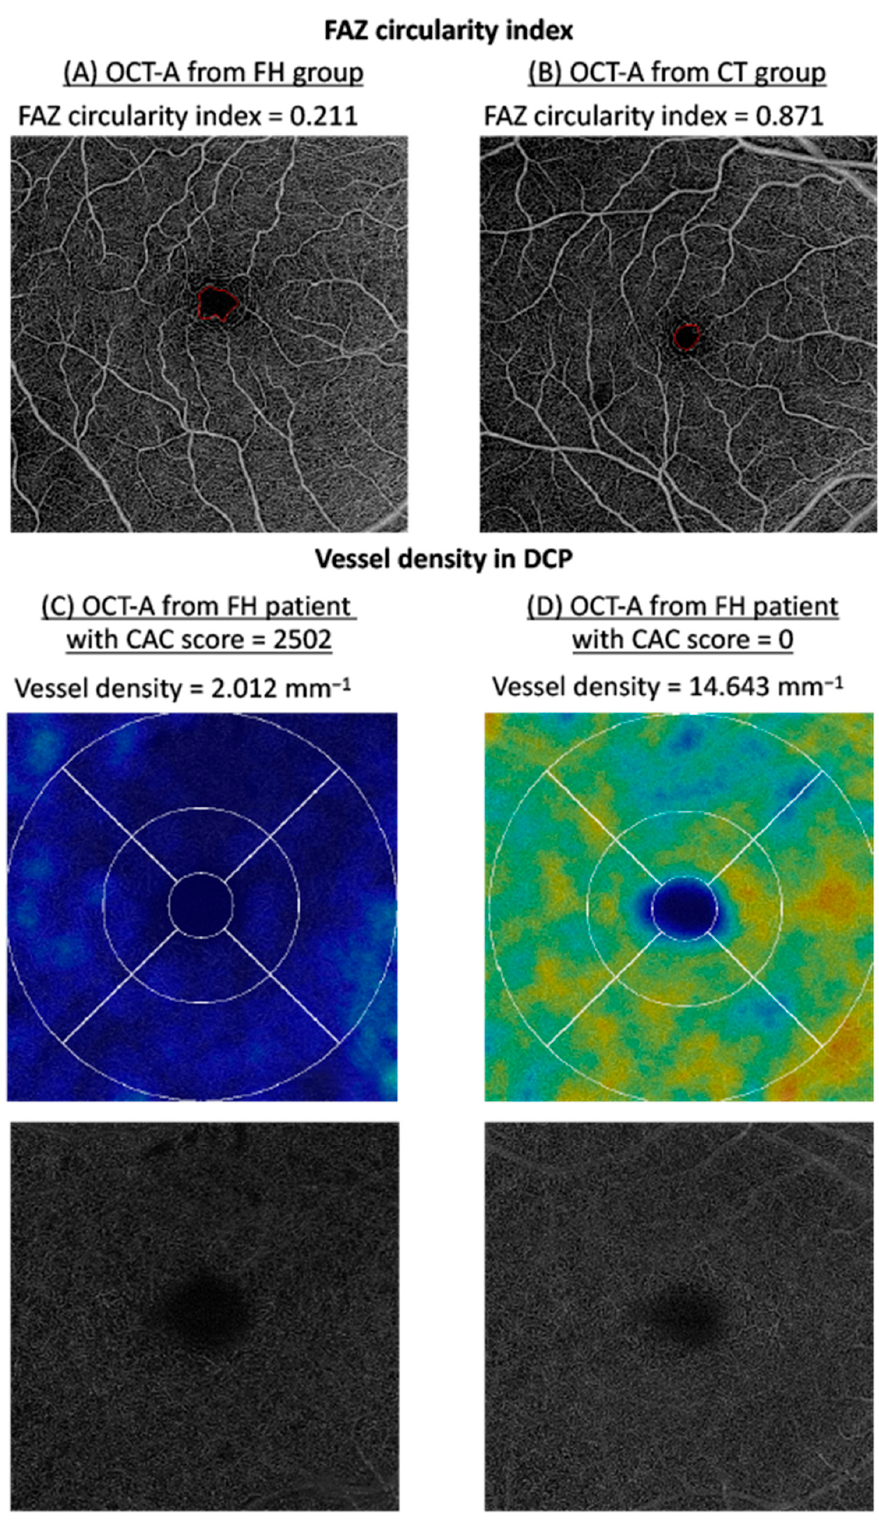
Figure 1. Examples of OCT-A images. Illustration of FAZ circularity index in FH group ( A ) and CT group ( B ) and vessel density in the DCP in FH patients with a high CAC score ( C ) and a low CAC score ( D ). FAZ: foveal avascular zone. OCT-A: optical coherence tomography angiography. FH group: familial hypercholesterolemia group. CT group: control group. CAC score: Coronary Artery Calcium score. mm: millimeter. mm − 1 : per millimeter.